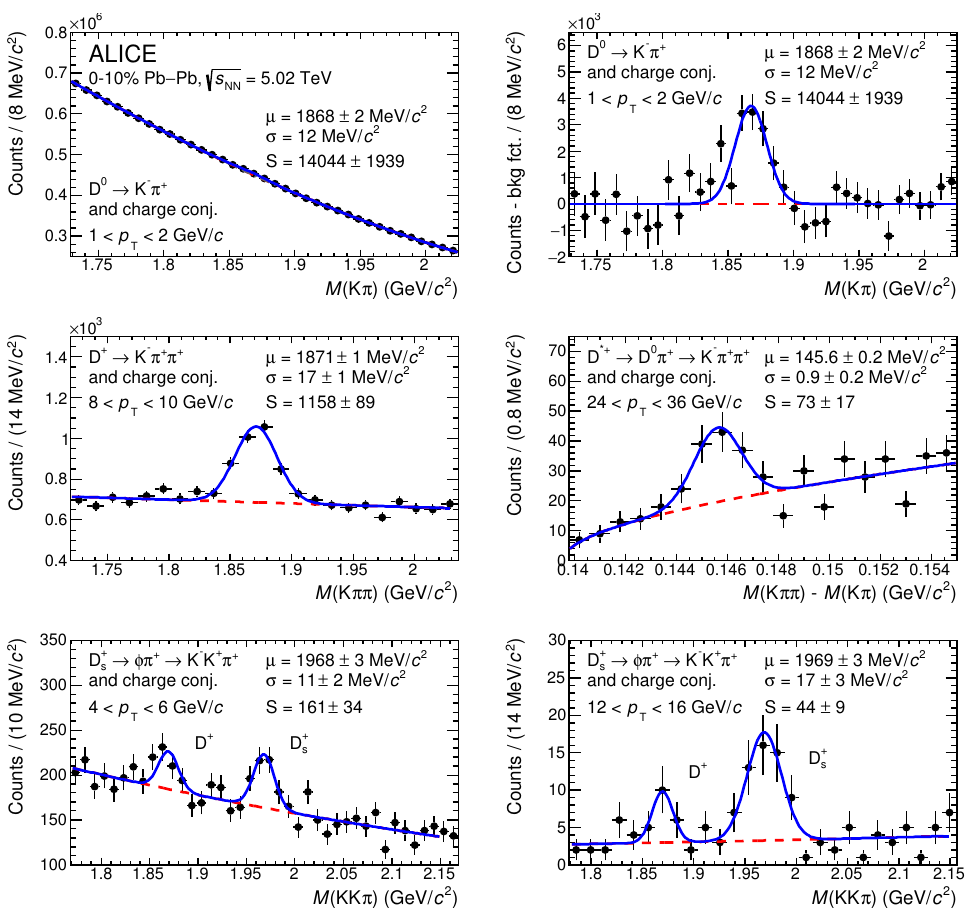
Figure 1 . Invariant-mass distributions for the four D-meson species in selected p T intervals for the centrality class 0{10%. Fitted values for the meson mass (cid:22) , width (cid:27) and raw yield S are also given. Top row: D 0 mesons with 1 < p T < 2 GeV =c , before (left) and after (right) subtraction of the background (cid:12)t function. For this p T interval, the width of the Gaussian used to describe the signal is (cid:12)xed to the value obtained in the simulations. Middle row: D + mesons with 8 < p T < 10 GeV =c and D (cid:3) + mesons (di(cid:11)erence of M (K (cid:25)(cid:25) ) and M (K (cid:25) )) with 24 < p T < 36 GeV =c . Bottom row: D + s mesons with 4 < p T < 6 GeV =c and 12 < p T < 16 GeV =c ; the D + ! K + K (cid:0) (cid:25) + signal is visible on the left of the D + signal. s D 0 p intervals 1{2 GeV =c and 2{3 GeV =c , where the background was found to be better T described by a second-order polynomial function (a fourth-order polynomial was used in 1{2 GeV =c for the 0{10% centrality class). The (cid:1) M distribution of D (cid:3) + candidates was (cid:12)tted with a Gaussian function for the signal and a threshold function multiplied by an p exponential for the background ( a (cid:1) M (cid:0) m (cid:1) e b ((cid:1) M (cid:0) m (cid:25) ) , where m is the pion mass and (cid:25) (cid:25) a and b are free parameters). The contribution of signal candidates that are present in the invariant-mass distribution of the D 0 meson with the wrong decay-particle mass assignment (re(cid:13)ection), was parametrised by (cid:12)tting the simulated re(cid:13)ection invariant-mass distribu- tions with a double Gaussian function, and it was included in the total D 0 (cid:12)t function. The ratio between the re(cid:13)ected signal and the yields of the D 0 was taken from simulations